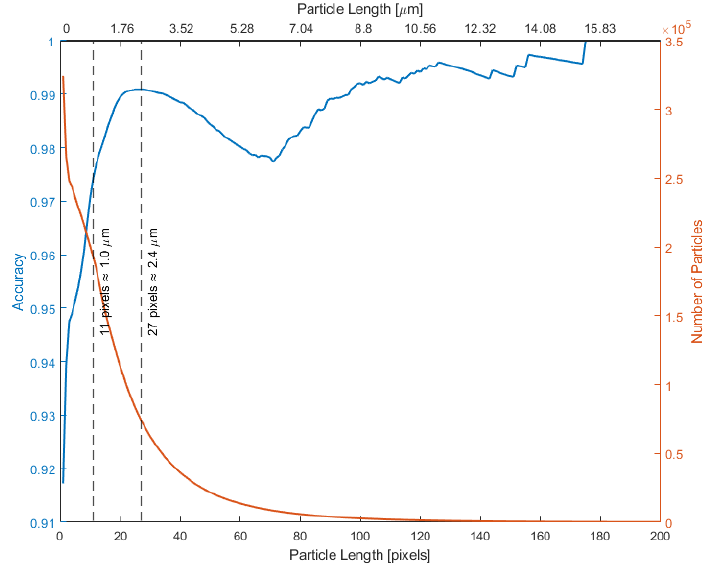
Figure 10. Effect of minimum particle size on accuracy (left blue axis) of the AMPI model built using transmitted light PP and CP image pairs. The total number of particles included in the model training set is also shown in the right orange axis.